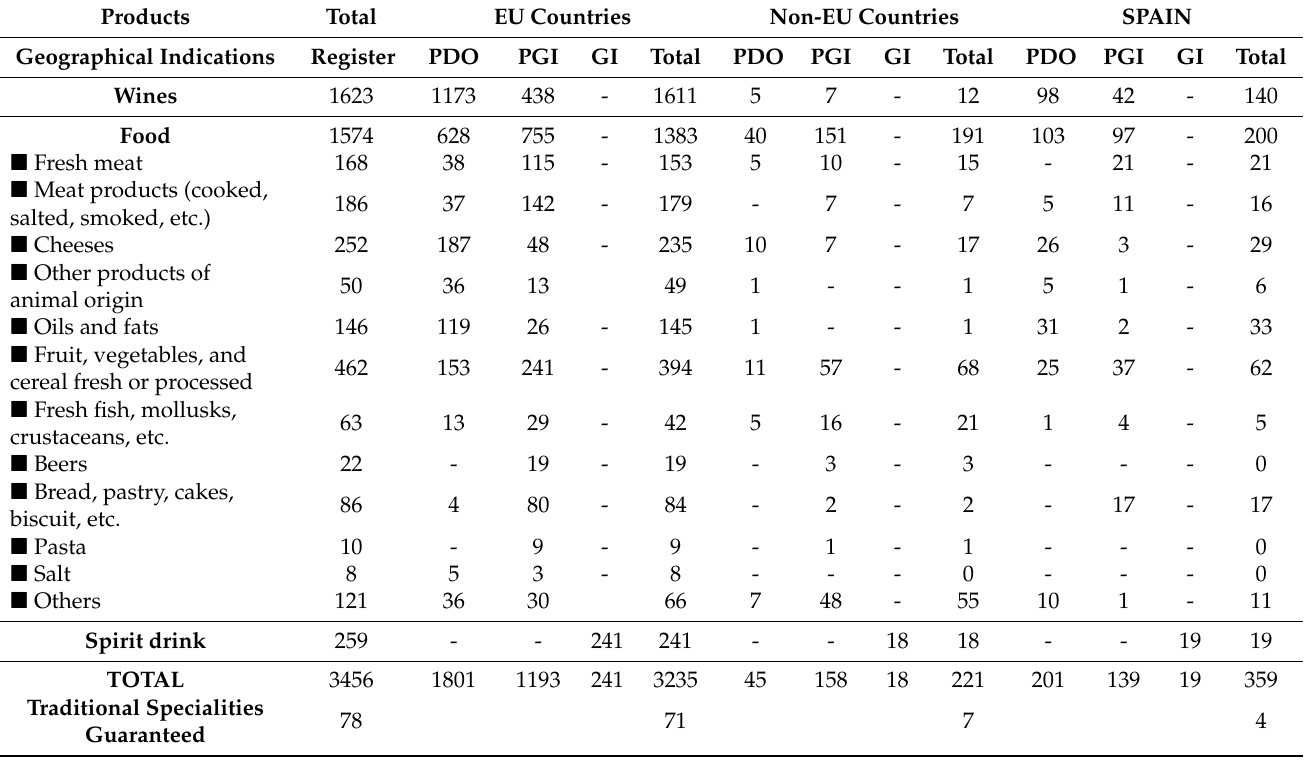
Table 1. Number of differentiated quality products under protection in the EU by registration categories and subcategories. Source: own elaboration. Data from the European Commission. eAmbrosia, EU Register of Geographical Indications (last consulted in January 2022).